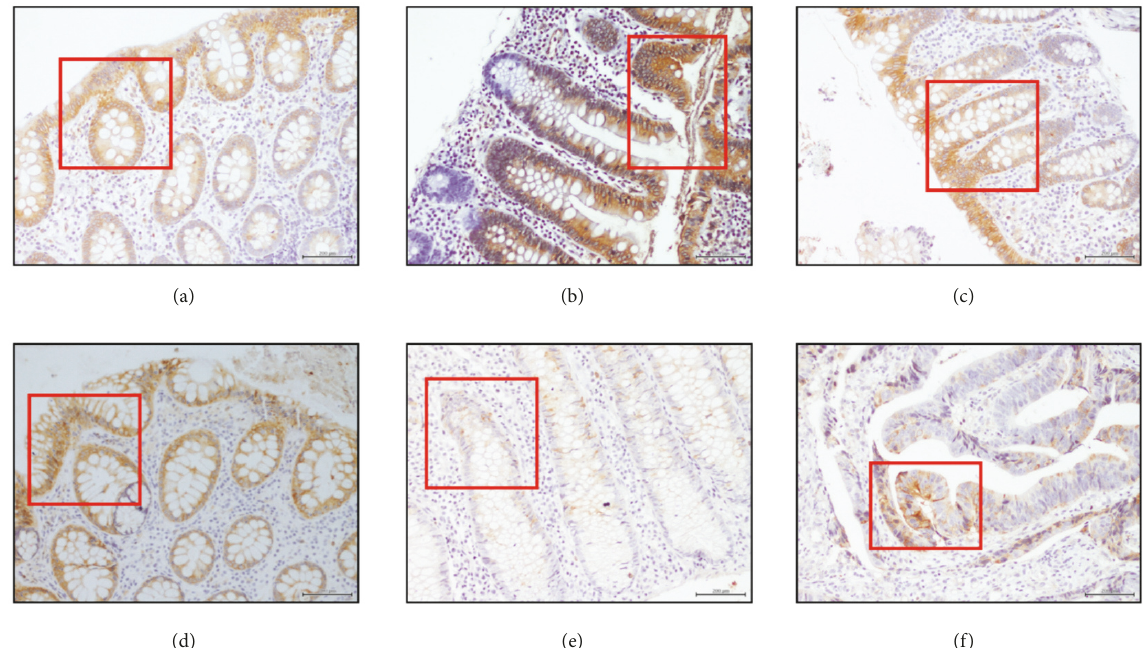
Figure 4: COX-2 immunoexpression in 114 patients. (a) Normal group (n=26). (b) C-IBS (n=31). (c) D-IBS (n=13). (d) CD (n=7). (e) UC (n=12). (f) CRC (n=25). Significant COX-2 protein in Normal and IBD groups with lesser expression in IBD and CRC. Magnification x40. Scale bar = 200 𝜇 m.